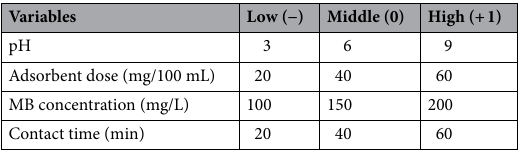
Table 1. Full factorial experimental design with factors and